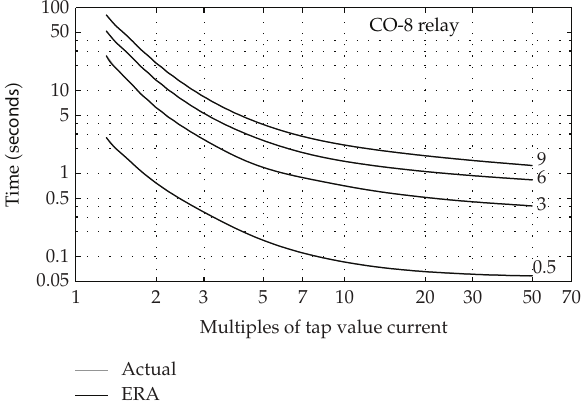
Figure 5: The actual characteristic curves and the curves fitted by (cid:3) 4.2 (cid:4) for the CO-8